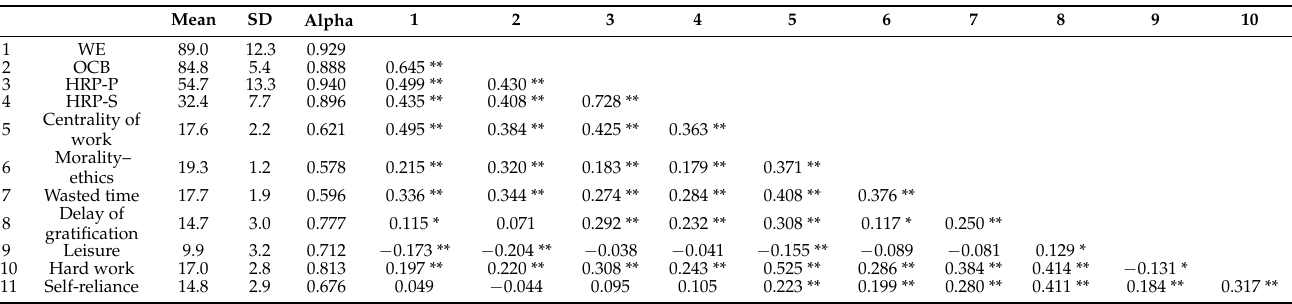
Table 1. Descriptive statistics and inter-correlations between the study